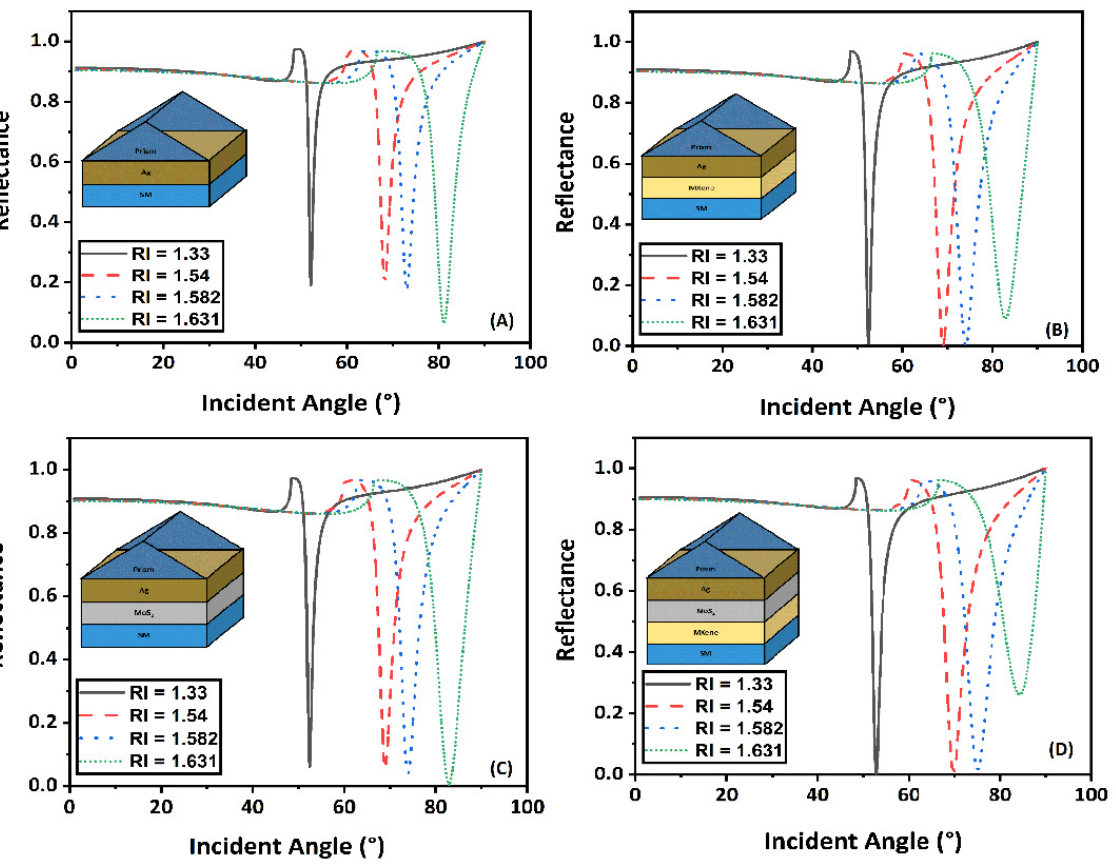
Figure 4. Change in reflectance with incident angle for different RI of sensing medium (A) = 0, 𝐺 = 0 , (B) 𝑀 = 0, 𝐺 = 1 , (C) 𝑀 = 1, 𝐺 = 0 , and (D) 𝑀 = 1, 𝐺 = 1 Table 2. Computed minimum reflectance and change in SPR angle values.